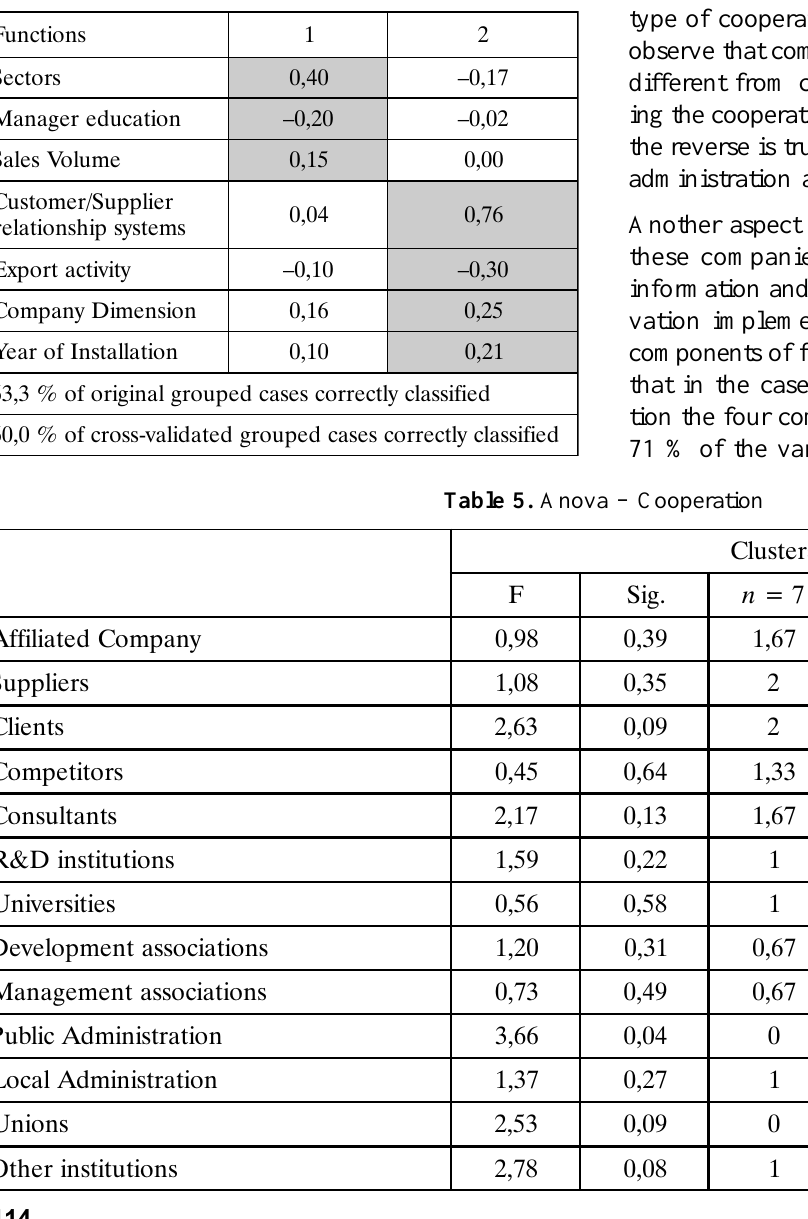
Table 4. Discriminant Analysis Structure Matrix